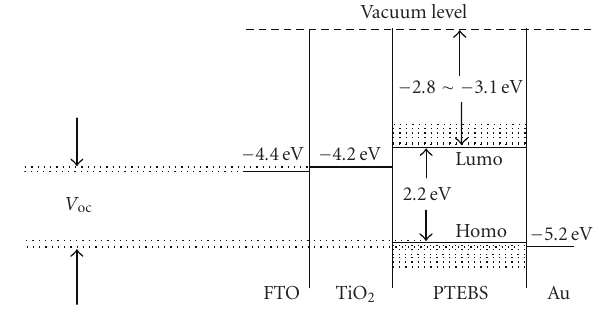
Figure 6: Energy level diagram for PTEBS/TiO 2 solar cell.